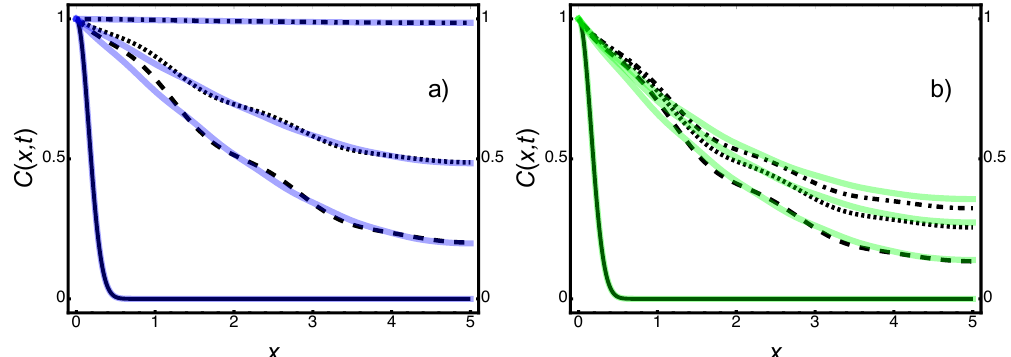
Figure 2. Evolution of the non-equilibrium concentration profiles of the tortuous (black lines) and winding pores (colour lines) in two different situations. In ( a ) we present the diffusion dynamics in the absence of adsorption. Since we have designed the pores for having the same effective diffusion coefficient D b ( z ) , then the concentration profile evolves equally in both pores. However, in ( b ) we show that the adsorption efficiency is different in both pores because it depends on the length of the walls (proportional to their enhancement factor γ ) which is larger in the tortuous pore (black lines) than in the winding pore (colour lines). This fact causes that less particles reach the exit side of the pore (at the right). See Appendix A for details of the